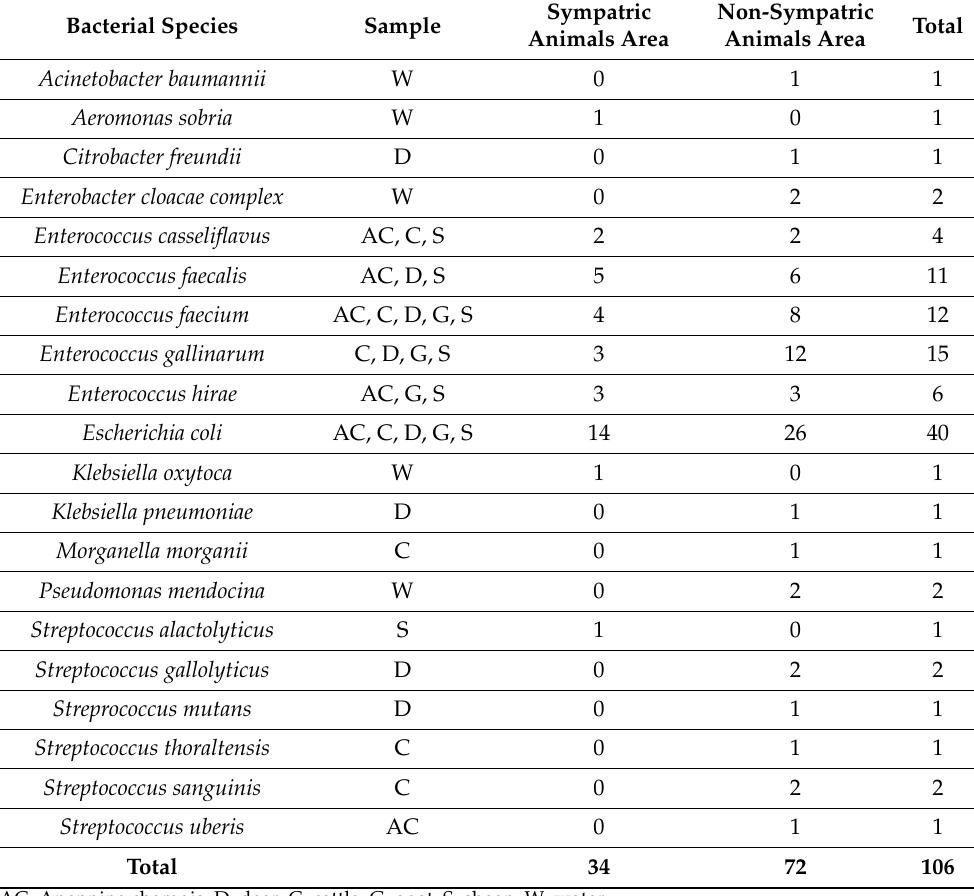
Table 1. Distribution of bacteria isolated from fecal and water samples collected in investigated areas of Maiella National Park where sympatric and non-sympatric animals were